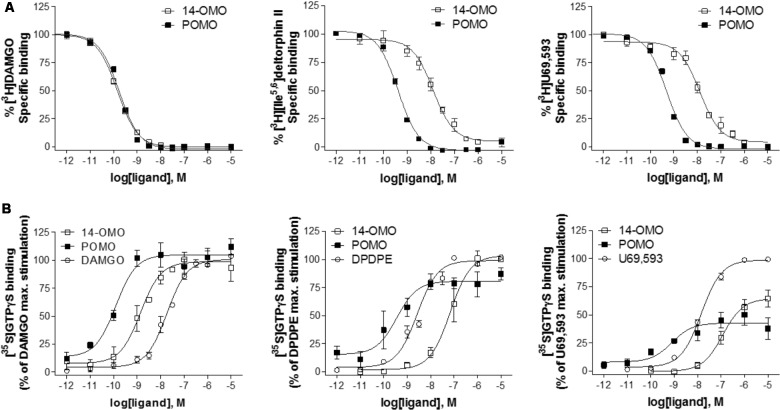
In vitro binding and agonist profile of POMO at the opioid receptors. (A) Concentration-dependent inhibition by POMO and 14-OMO of [3H]DAMGO (MOR) and [3H][Ile5,6]deltorphin II (DOR) binding using rat brain membranes, and by [3H]U69,593 (KOR) using guinea-pig brain membranes, determined in competition binding assays. (B) Concentration-dependent stimulation of [35S]GTPγS binding by POMO and 14-OMO determined in the [35S]GTPγS binding assays using membranes from CHO cells expressing human opioid receptors. Percentage stimulation is presented relative to the maximum simulation of reference agonists DAMGO (MOR), DPDPE (DOR), and U69,593 (KOR). Values are expressed as the mean ± SEM (n ≥ 3).